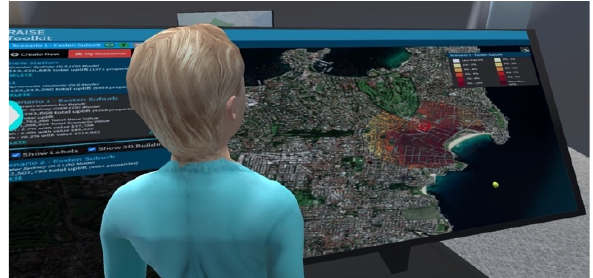
Figure 6: A user exploring an urban plan. In the bottom right, a pointer showing the mouse position is presented in yellow.